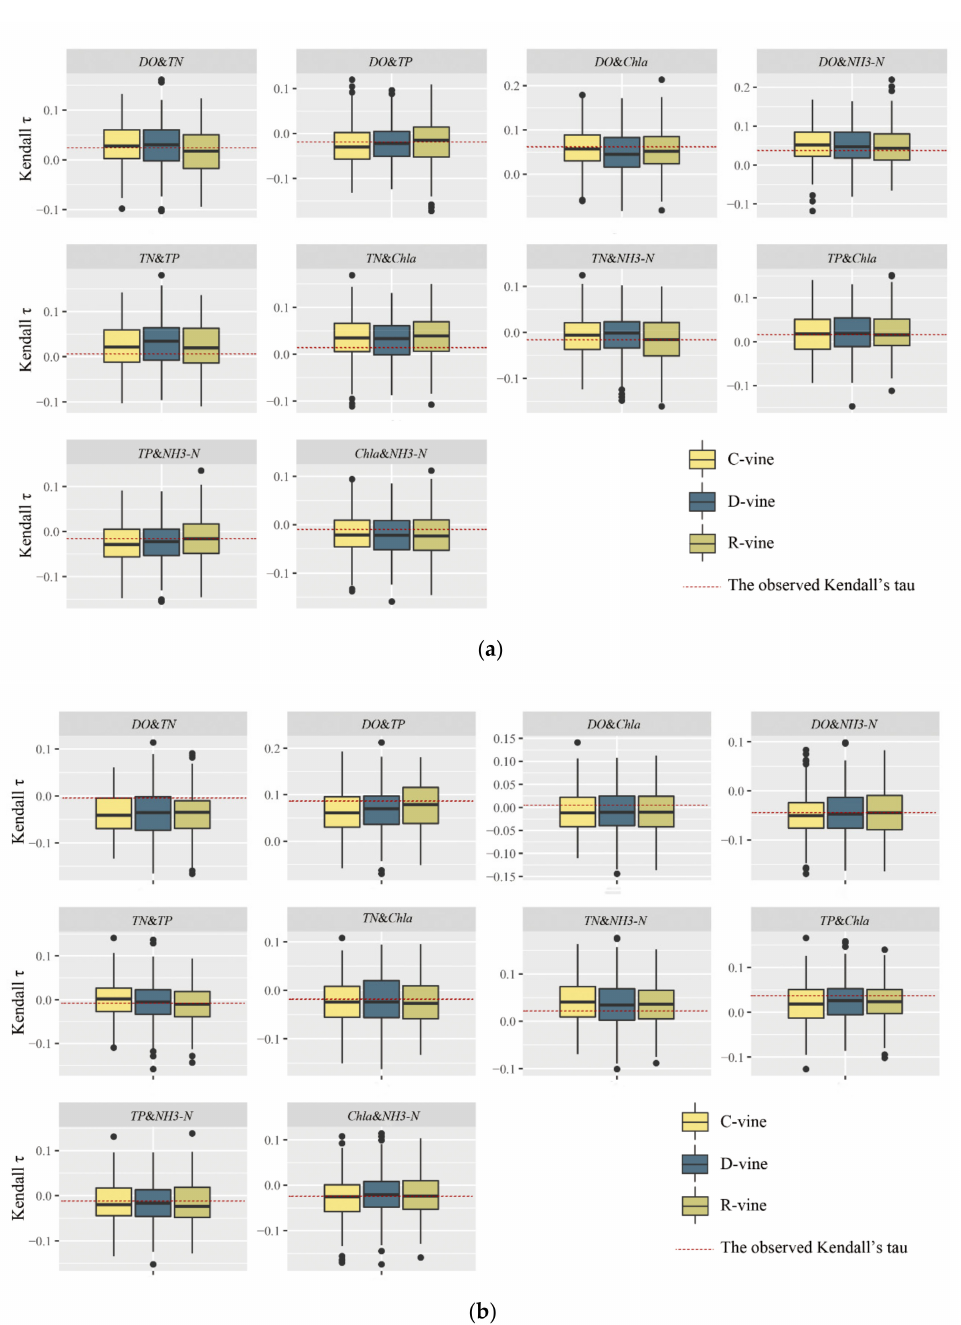
Figure 6. Comparisons of the observed and simulated Kendall’s tau among C-, D-, and R-vine in the period of B-IRSN ( a ) and A-IRSN ( b ). The red lines refer to the observed Kendall’s tau coe ffi